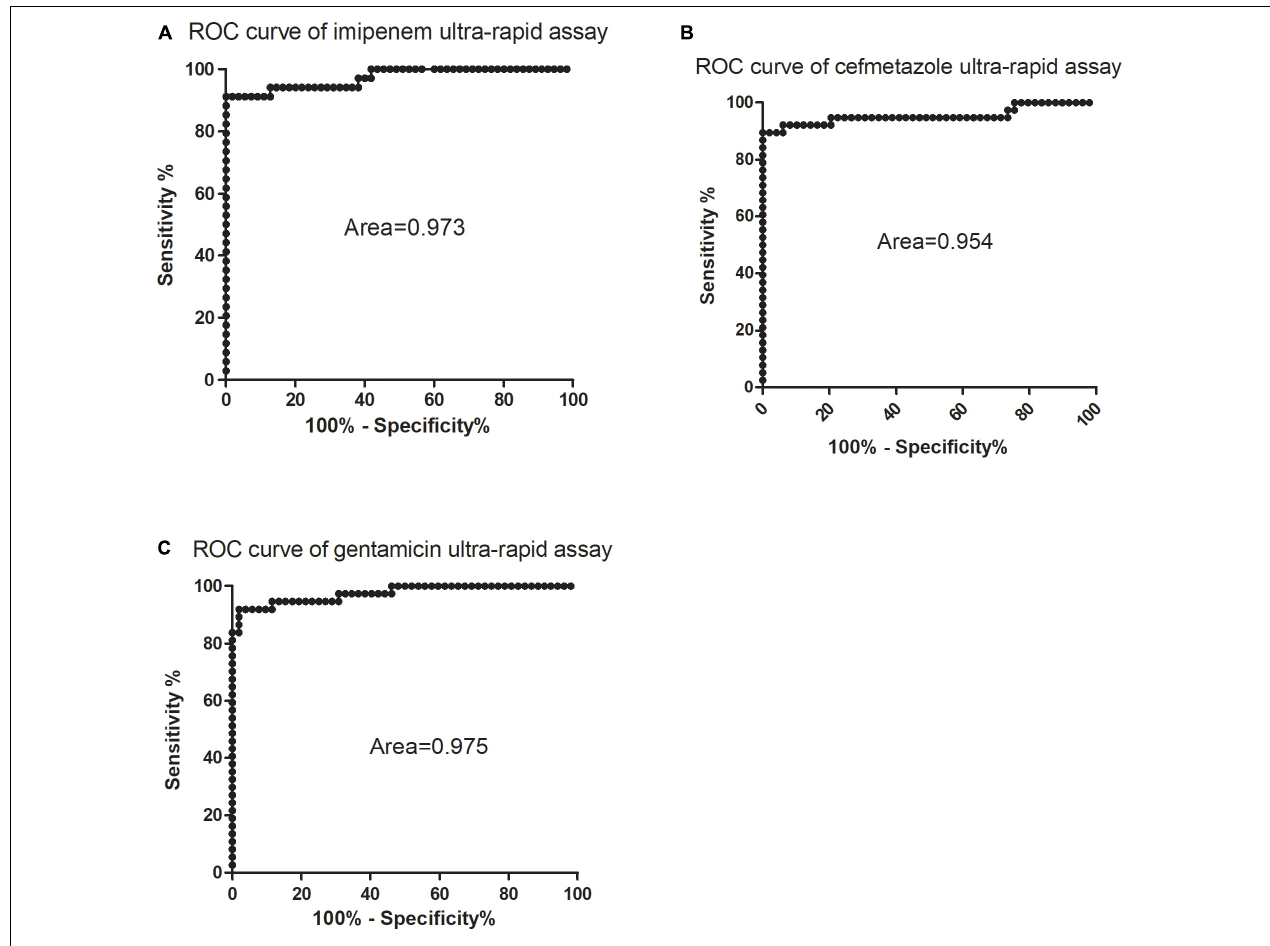
FIGURE 4 | Receiver operating characteristic (ROC) curves for diagnosis of (A) imipenem, (B) cefmetazole, and (C) gentamicin susceptibility of K. pneumoniae by SYBR Green I/PI staining assay. The ROC curves were constructed using relative membrane permeability (RS) values and the phenotypic drug susceptibility. All intermediate and sensitive isolates were treated as the control group, and the resistant isolates were treated as the non-control